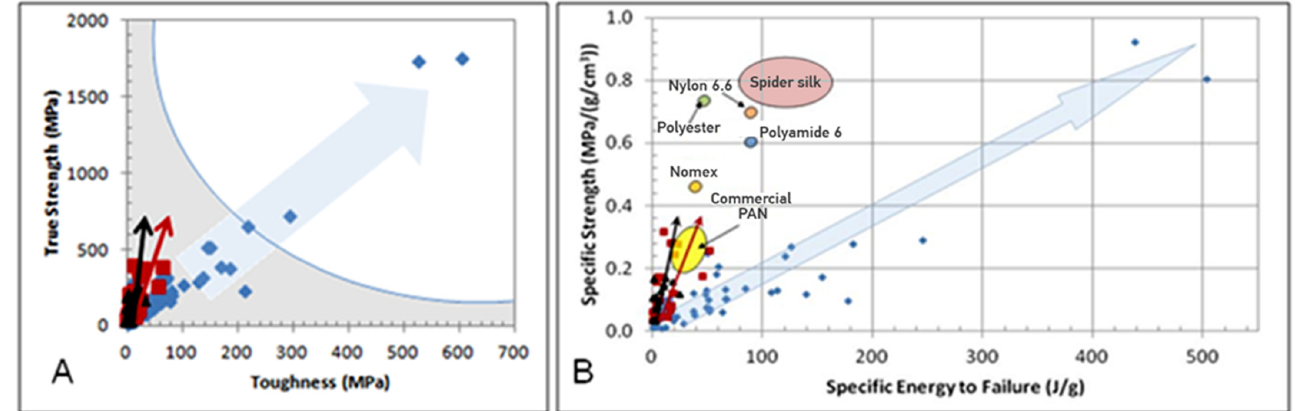
Figure 5. Correlations of normal materials behavior, the structural materials have a trade-off between strength and toughness; ( A ) correlation between toughness and strength compared to as-spun PAN composite nanofibers and annealed composite nanofibers, high strength is often obtained at the expense of low toughness and vice versa, gray area; ( B ) comparison of the strength and energy required for failure of PAN composite nanofibers used in this research (test report) with selected materials [36].